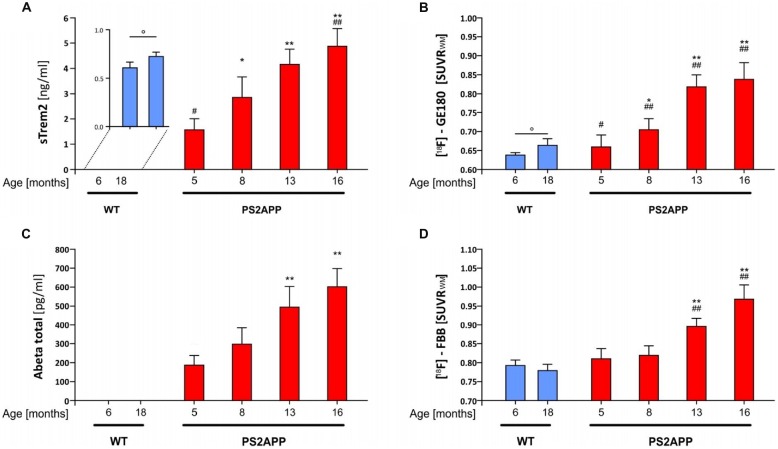
Soluble triggering receptor expressed on myeloid cells 2 (sTREM2) increases in an age dependent manner in brains of PS2APP mice. (A)
Post mortem levels of sTREM2 were quantified by ELISA from forebrain tissue at indicated time-points (n = 4–8 mice per group). (B) Forebrain in vivo glial activation assessed by 18-kDA translocator protein (TSPO) [18F]-GE180 μPET is presented as standard-uptake-value-ratios (SUVR) relative to white matter reference tissue uptake (n = 8 mice per group). (C)
Post mortem levels of total β-amyloid peptide (Aβ) were quantified by ELISA from forebrain tissue at indicated time-points (n = 4–8 mice per group). (D) Forebrain in vivo amyloidosis assessed by [18F]-florbetaben μPET is presented as SUVR relative to white matter reference tissue uptake (n = 8 mice per group). Data information: in (A–D), data are presented as mean ± SD. *significant differences in PS2APP mice vs. their 5 month old littermates (*p < 0.05; **p < 0.001); #significant differences in PS2APP mice vs. age-matched wild-type (WT; #p < 0.05; ##p < 0.001); °significant differences between young and aged WT (°p < 0.05). Analysis of variance (ANOVA) with Tukey post hoc applies for all. Please note that data of (B,D) were partially previously published (Brendel et al., 2016).